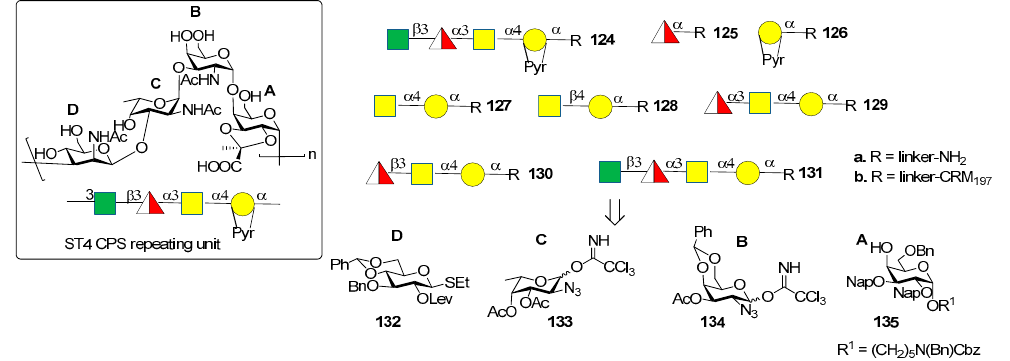
Figure 14. Repeating unit of ST4 CPS and synthesis of ST4 CPS fragments in the pyruvalated form and the nonpyruvalated variant, as reported in [84].